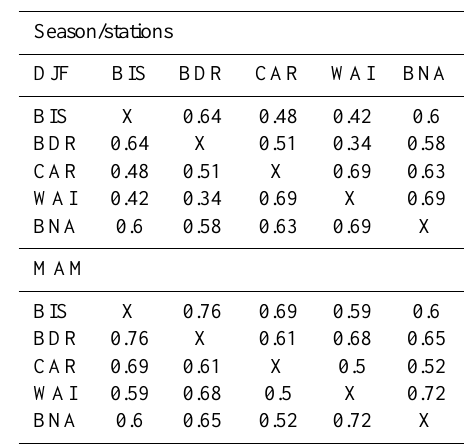
Table 3. Pattern correlation of the net influence of extremes on win- ter (DJF) and spring (MAM) mean column ozone among the five US ozone monitoring sites. For station code see Fig.